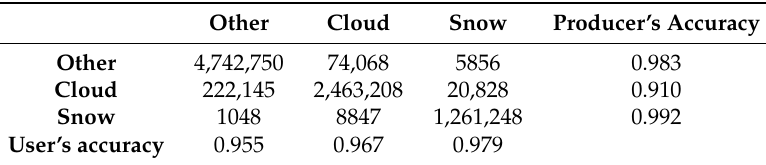
Table 3. Confusion matrix of trained